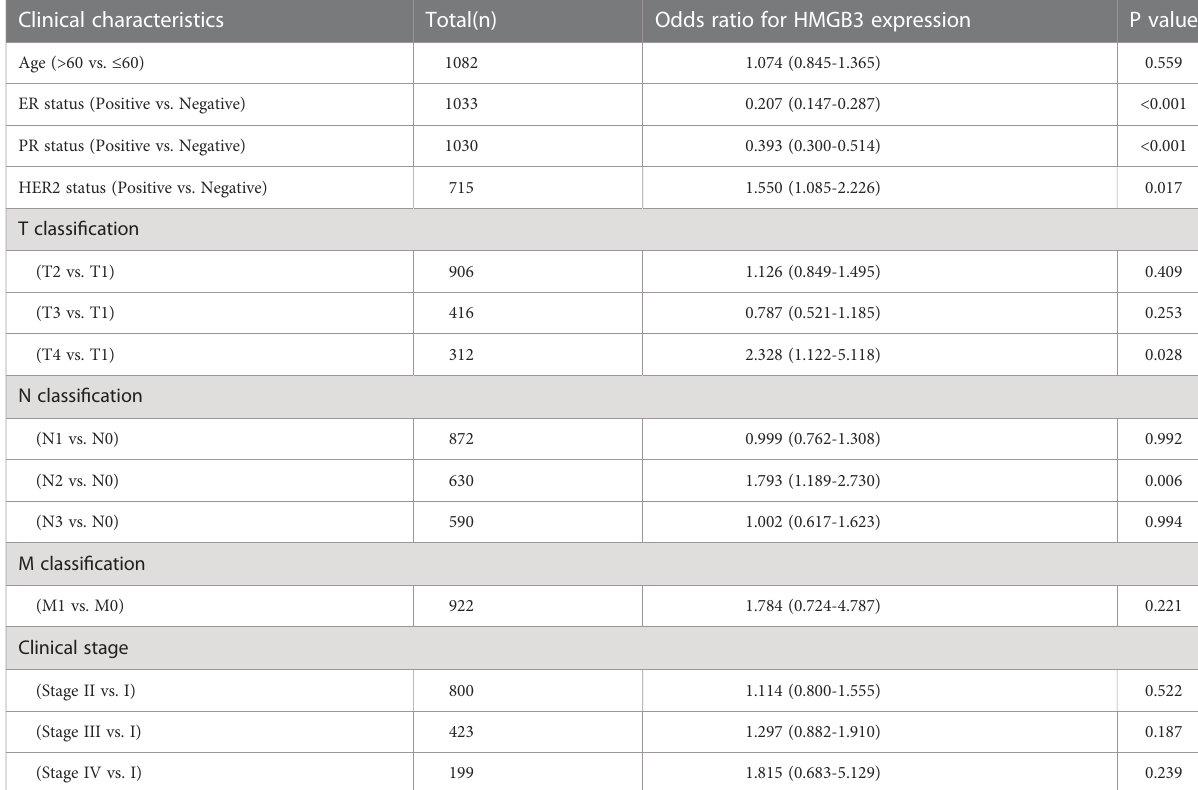
TABLE 1 Association of HMGB3 expression with clinicopathologic characteristics by logistic regression. Clinical